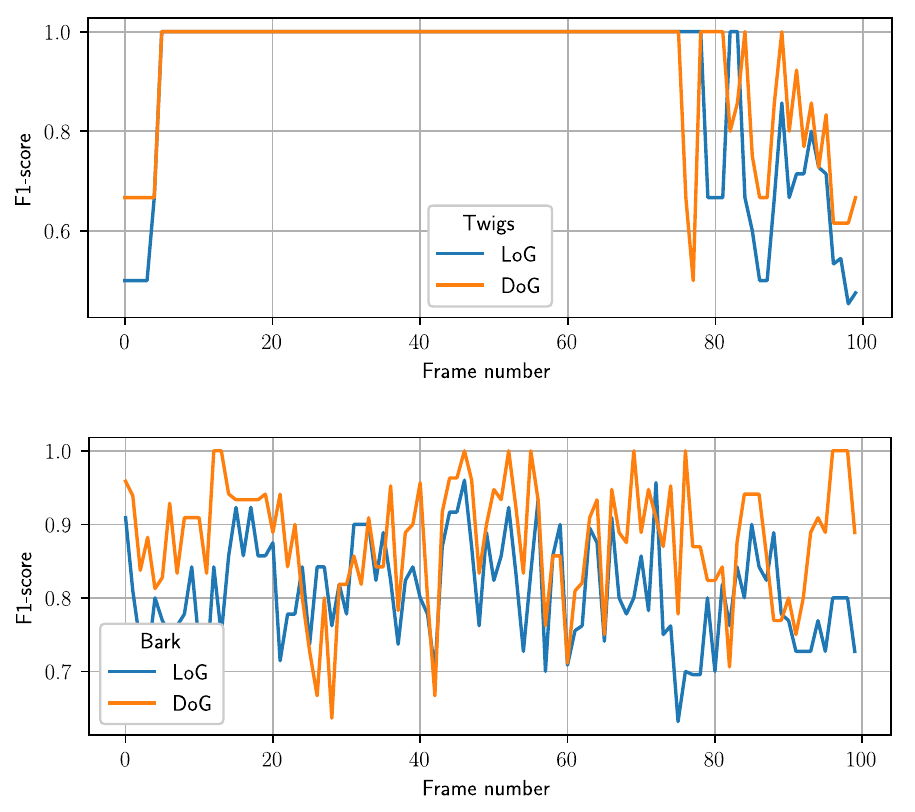
Figure 7. Relative comparison of LoG and DoG algorithms. High accuracy of F1-score for twigs between the 5th and 75th frames is related to a small number of twigs.